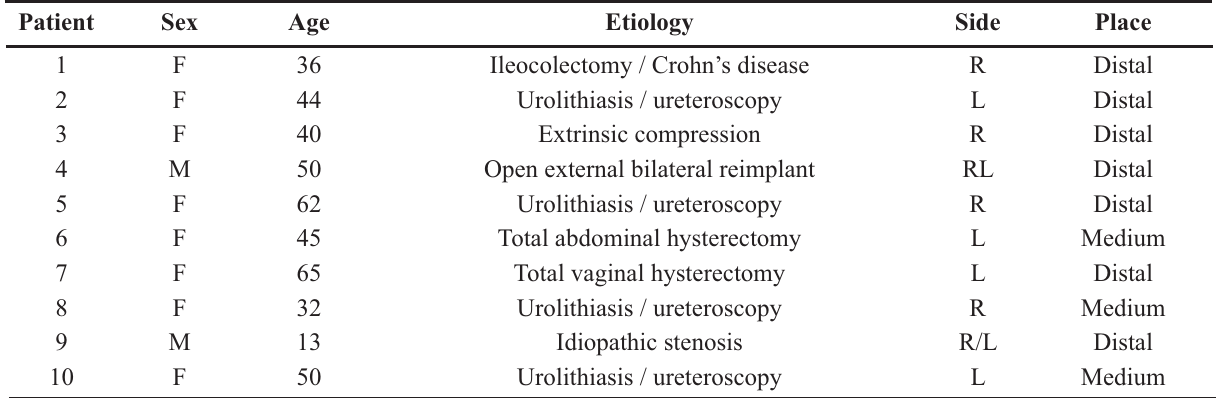
Table 1 – Patient demographic and clinical data.